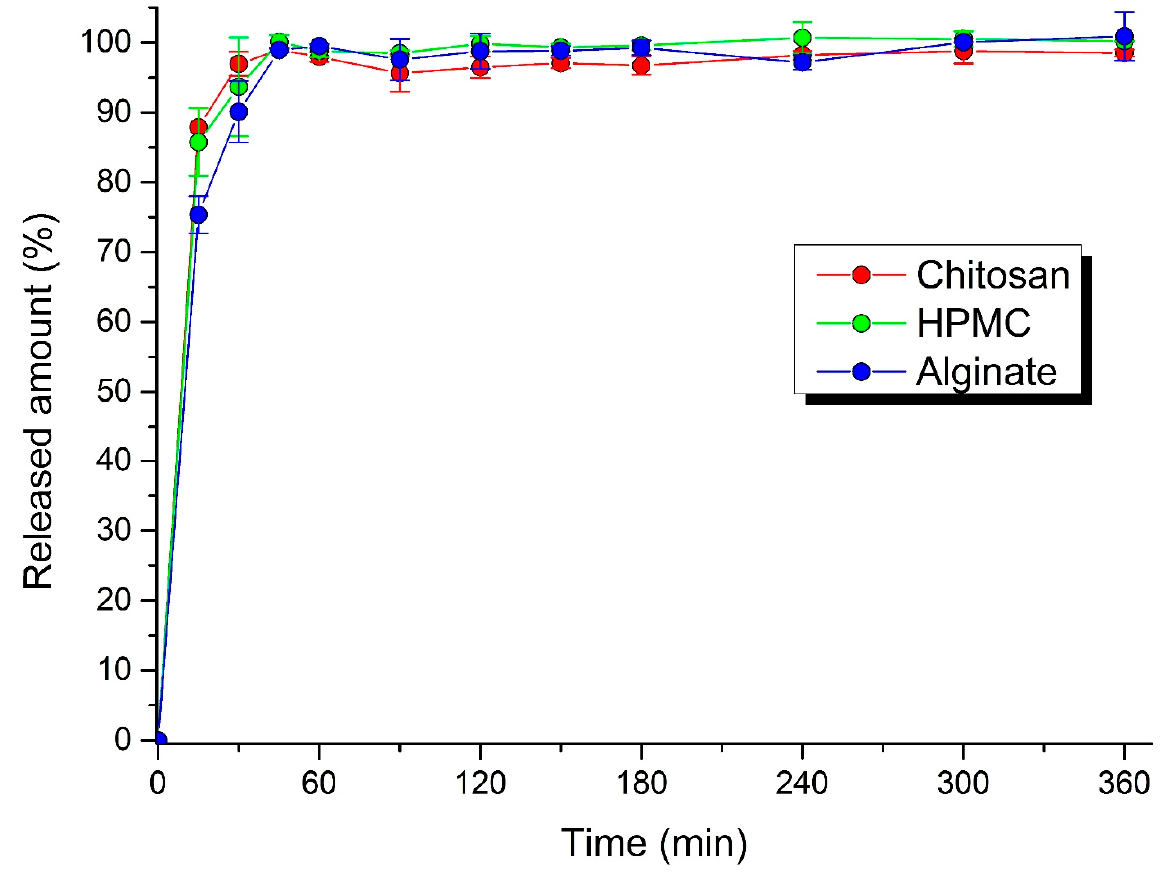
Figure 6. Dissolution profiles of pellets filled in hard gelatin capsules in gastric fluid.